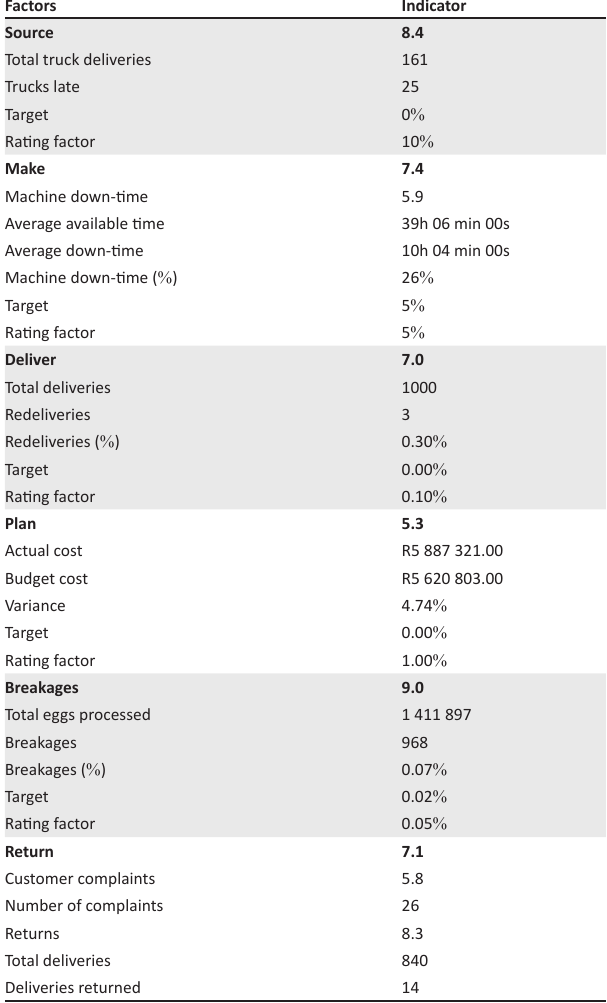
TABLE 10: Developed model: Reliability